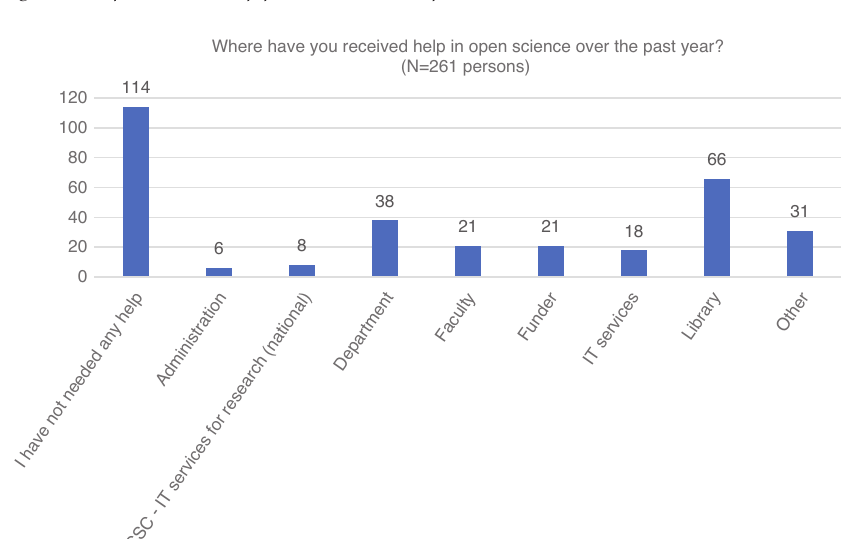
Fig. 9: The open science help providers (N=261